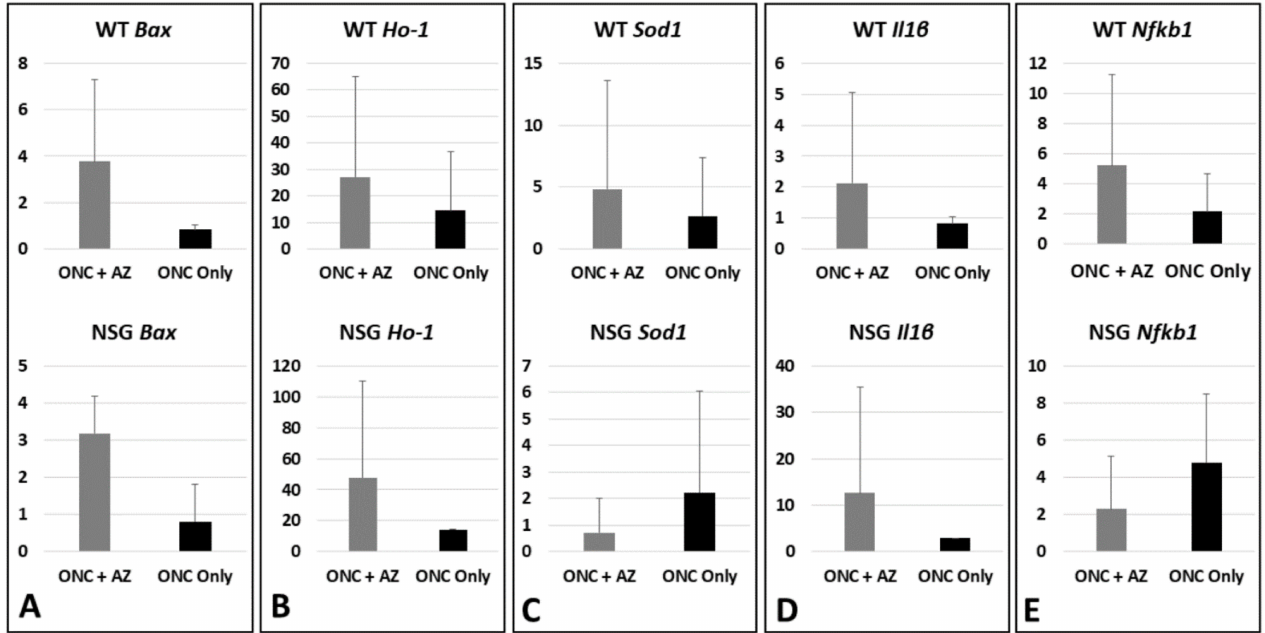
Figure 4. Molecular analysis of the optic nerves, day 3 after ONC. ( A ) Bax expression levels in WT and NSG mice remained at baseline without treatment and increased with AZ treatment. ( B ) Ho-1 levels in WT and NSG mice increased without treatment and further increased with AZ treatment.